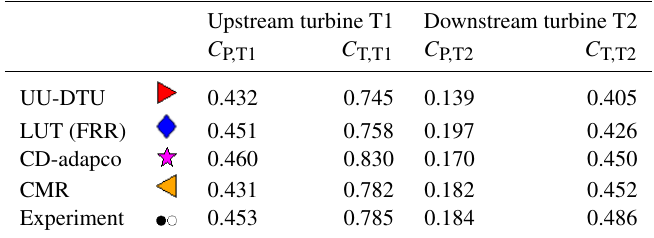
Figure 9. Power coefficient C P (a) and thrust coefficient C T (b) for T1 (filled symbols) and T2 (empty circles) compared for test case C. The downstream turbine T2 is positioned at x/D = 5.18 downstream of T1, and the upstream turbine T1 is operated at λ T1 = 6.0. The reference velocity U ref = 11.5ms − 1 is the velocity experienced by T1 at hub height. Table 7. Numerical values of power coefficient C P and thrust coefficient C T for test case C. The downstream turbine T2 is positioned at 5.18 D downstream of T1. T1 is operated at λ T1 = 6.0 and T2 is operated at λ T1 = 4.5, referring to the reference velocity U ref = 11.5ms − 1 measured at hub